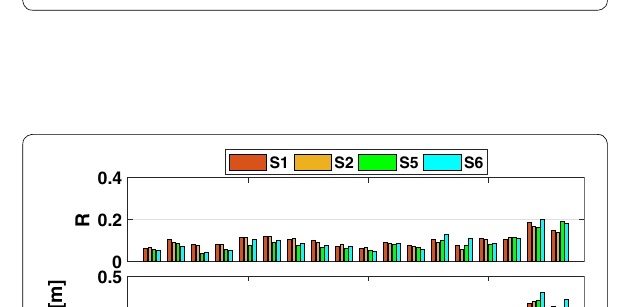
Fig. 9 BDS-3 OBD of each POD arc